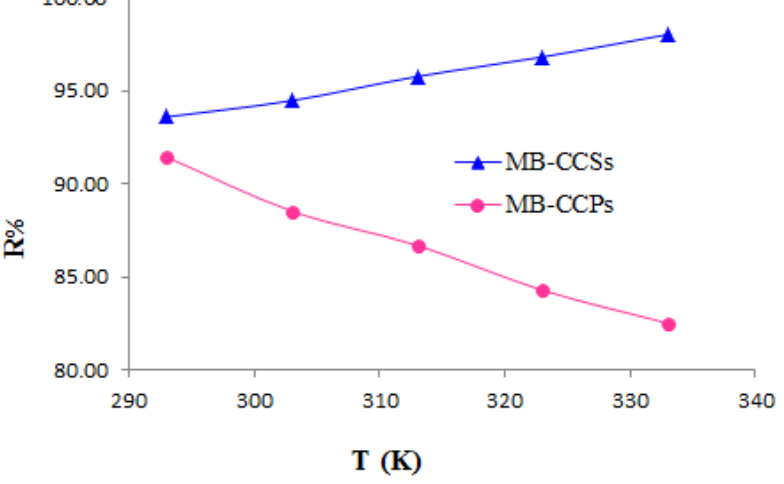
Figure 8. Impact of temperature on MB removal efficiency using CCSs and CCPs.